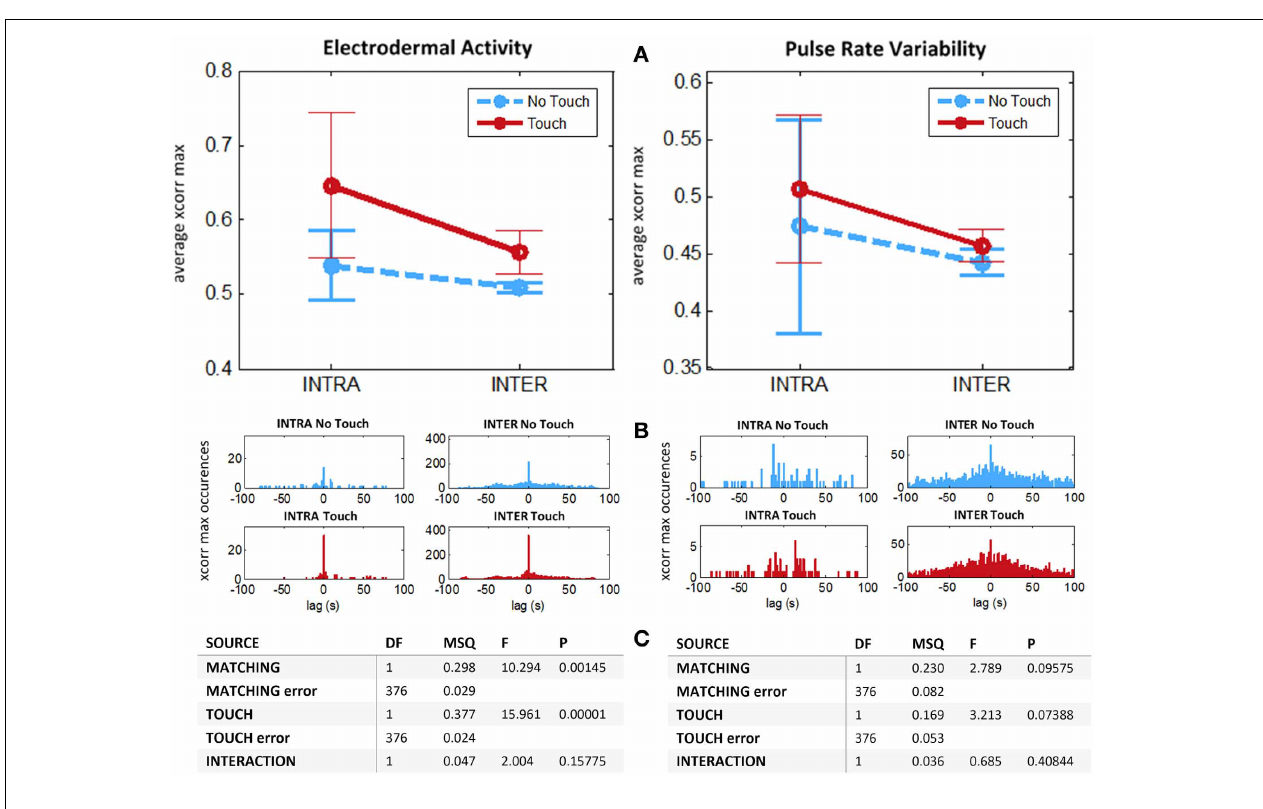
FIGURE 6 | Average intersubject maximum cross-correlations for experimental (INTRA) and surrogate (INTER) data. N = 14 couples. For each run we compute the average cross-correlation after z-transform for interval ( − 1, 1s) around maximum value. Left: Electrodermal Activity. Right: